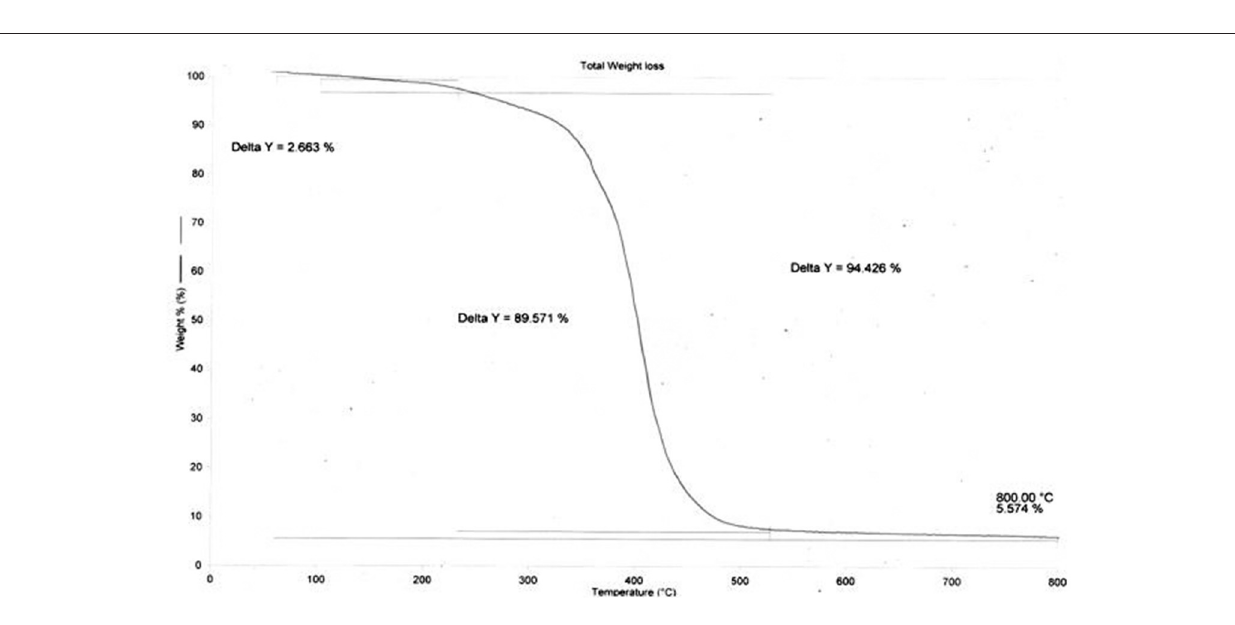
FIGURE 3 | Thermo gravimetric plot of binder